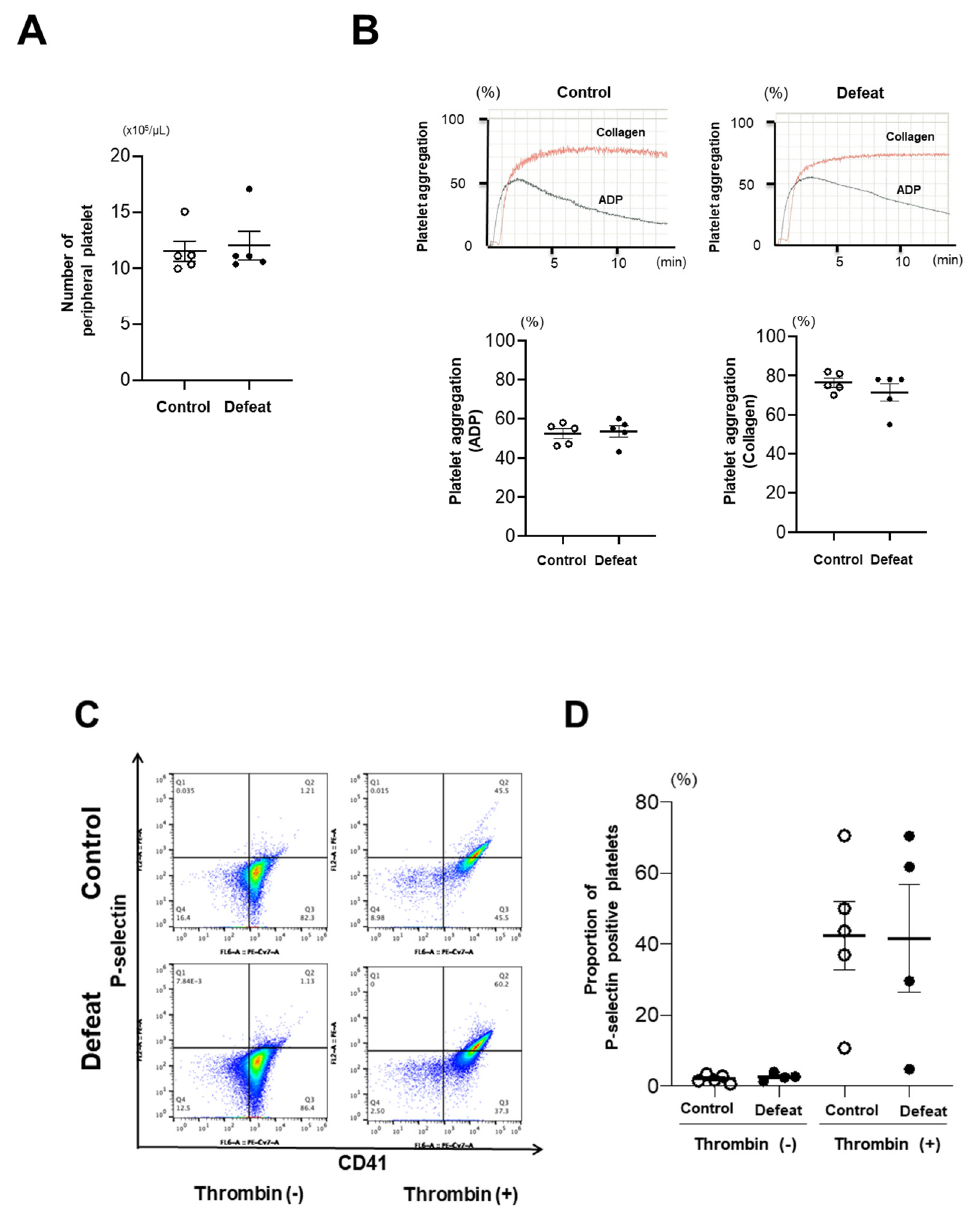
Figure 4. Platelet aggregation and P-selectin expression are comparable between control and defeated mice. ( A ) Number of peripheral platelets before FeCl 3 application. Values represent mean ± standard error of mean (SEM) for five control and five defeated mice. ( B ) Platelet aggregation on either ADP or collagen activation. The black line represents platelet aggregation on ADP stimulation. The red line represents platelet aggregation on collagen stimulation. Values represent mean ± standard error of mean (SEM) for five control and five defeated mice. ADP, adenosine diphosphate. ( C , D ) Flow cytometric analysis of P-selectin expression in platelets from control and defeated mice. Values represent mean ± standard error of mean (SEM) for six control and six defeated mice without thrombin and for six control and five defeated mice with thrombin.